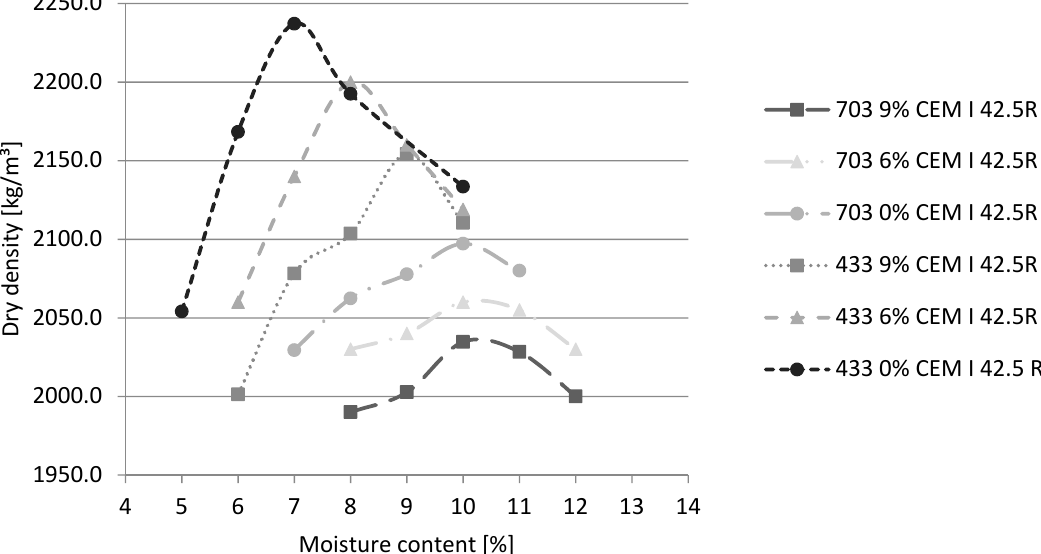
Figure 3. The relationship between dry density and moisture content for different soil mixtures.